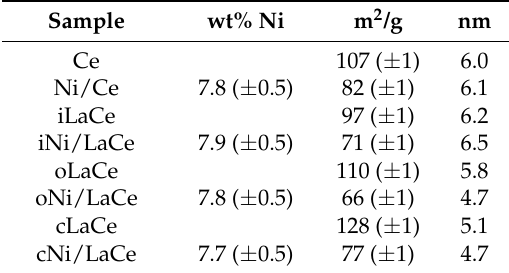
Table 2. Physicochemical properties of the Ni samples (Nickel amount calculated via Atomic Adsorption, Surface area via BET equation and Average pore diameter via BJH